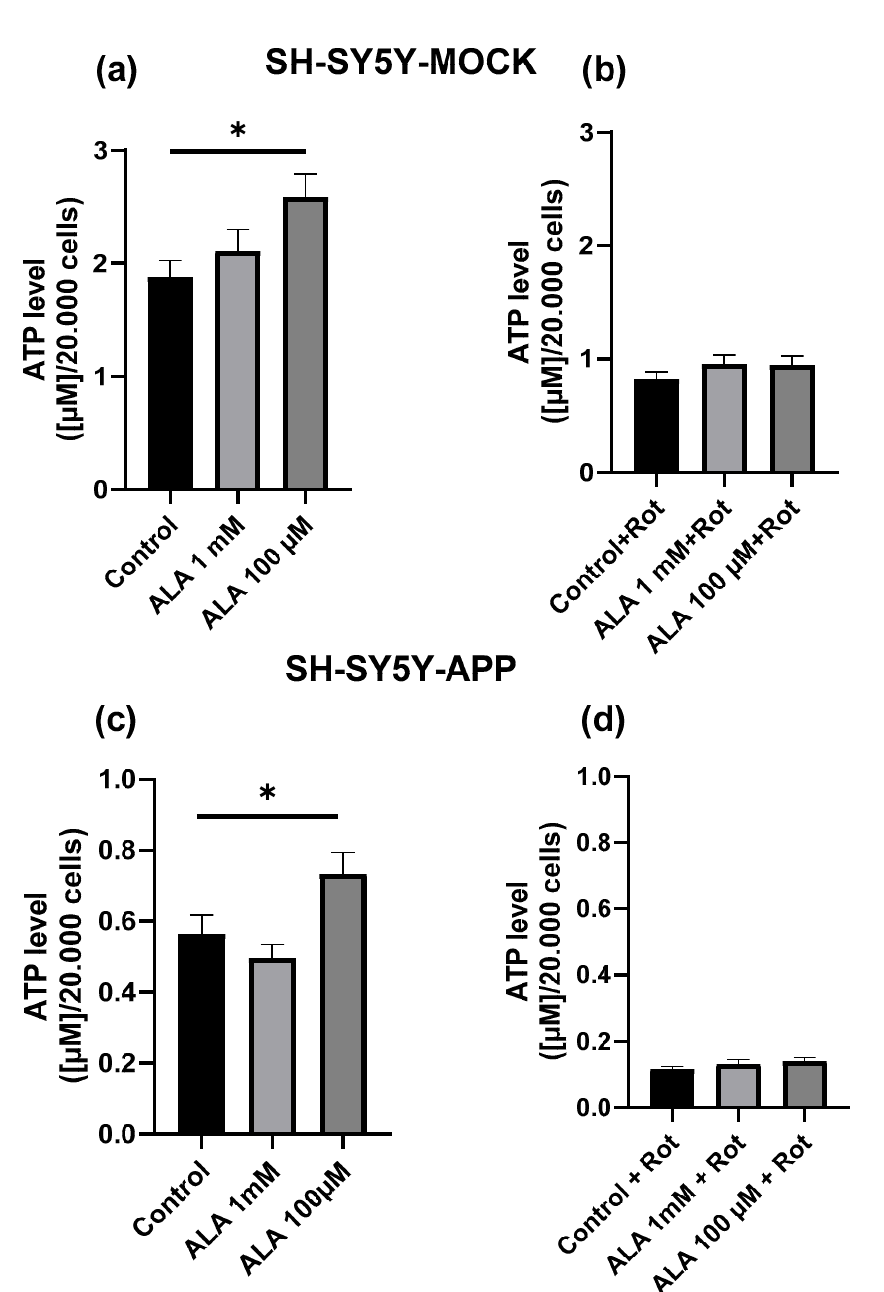
Figure 1. ATP levels in SH-SY5Y-MOCK after alpha lipoic acid (ALA) treatment. ( a ) Cells were incubated with ALA at different concentrations for 24 h and measured against cells treated with ethanol the solvent of ALA. ( b ) ATP levels in rotenone (Rot) [25 µ M]-treated SH-SY5Y-MOCK cells. Before rotenone impairment, SH-SY5Y-MOCK cells were incubated with either ALA 100 µ M, 1 mM, or ethanol for 1 h before exposure to 25 µ M rotenone for another 24 h. SH-SY5Y-APP 695 were treated likewise. ( c ) Treatment with ALA. ( d ) Additional rotenone. Data are displayed as the means ± SEM. N = 17–22. Statistical significance was tested via one-way ANOVA and Tukey’s post-hoc test (* p < 0.05).